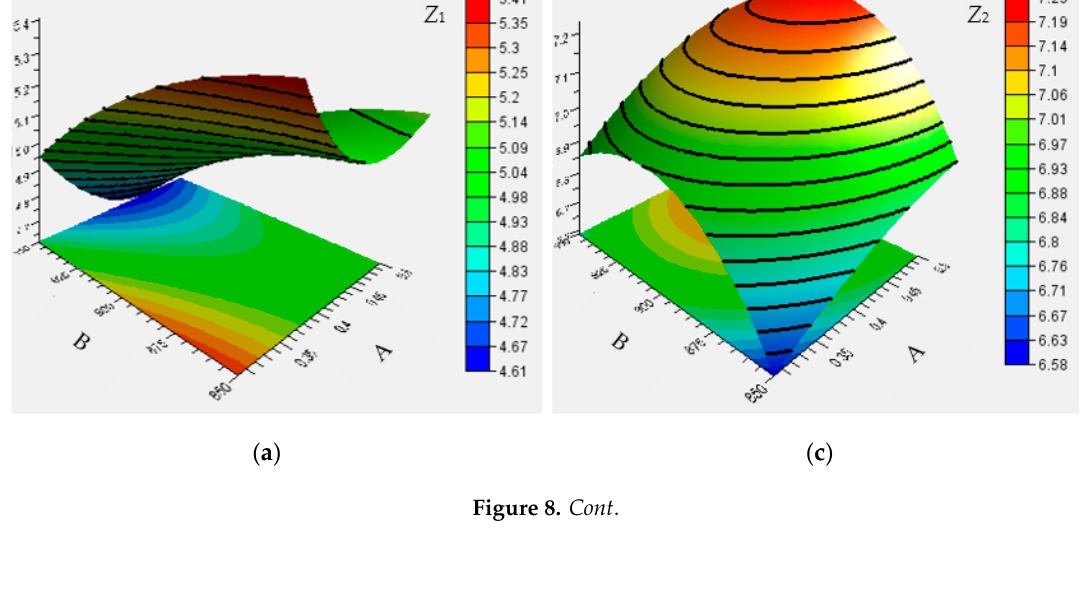
( d ) Figure 8. ( a ) A and B on Z 1 , ( b ) A and B on Z 2 , ( c ) E and F on Z 1 , ( d ) E and F on Z 2 . When the friction coefficient increases, the flow resistance of the sheet metal increases, resulting in a gradual decrease in the thickening rate. When the austenitizing temperature increases, the fluidity of sheet metal increases, the deformation ability of sheet metal increases at high temperature, and the thickening trend is inhibited. The prolongation of the holding time inhibits the springback degree of the sheet metal and decreases the thickening trend. The increase in the temperature in the heating area makes the cooling rate of the high ‐ temperature parts slow and increases the probability of the springback phenomenon, which leads to an increase in the thickening rate. When the binder force cannot press the sheet, it does not play a major role in the thickening rate. When the binder force is large enough, the flow capacity of the sheet becomes worse, and the thickening trend is inhibited. The maximum thinning rate in the slow cooling zone increases significantly with the increase in the friction coefficient and decreases slightly with the increase in the austenitizing temperature, and it gradually increases with the extension of the dwell time, and decreases first and then increases as the temperature of the heating zone increases. With the increase in the binder force of the upper die, the binder force increases significantly, and with the increase in the fine mesh binder force, it shows a trend of first decreasing and then growing. This is because the increase in the friction coefficient can hinder the sheet metal flow and increase the thinning degree. The increase in the austenitizing temperature is beneficial to the sheet metal flow. With the increase in the upper binder force, a trend of first decreasing and then increasing with the increase in the detail pressing force is observed. The prolongation of the holding time can effectively inhibit the springback trend of the thinned material and increase the thinning rate. When